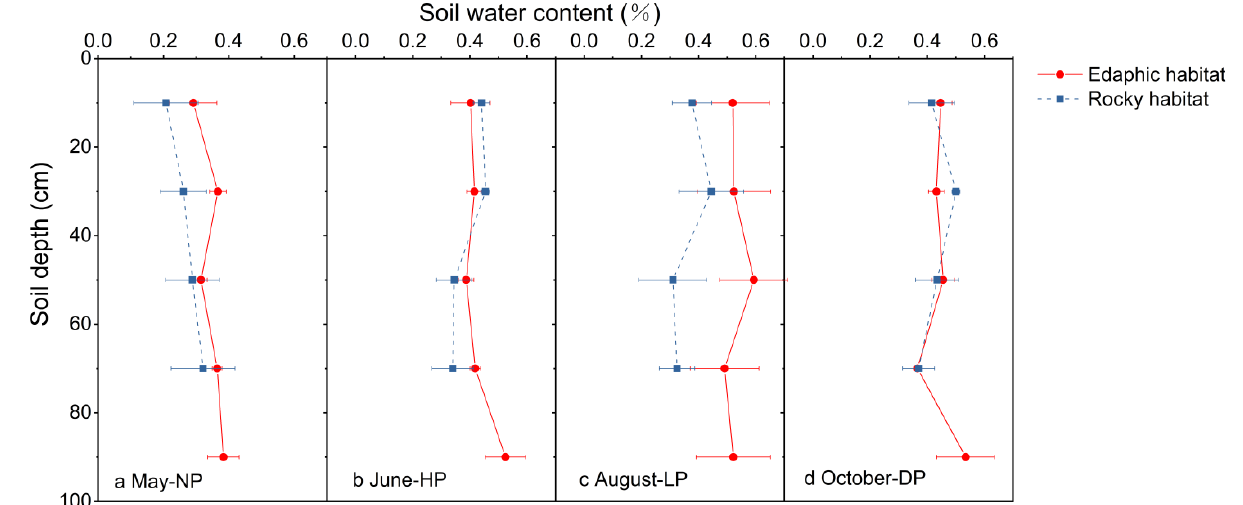
Figure 5. Variation in mean (±S.D.) soil water content along the soil profile during the wet season